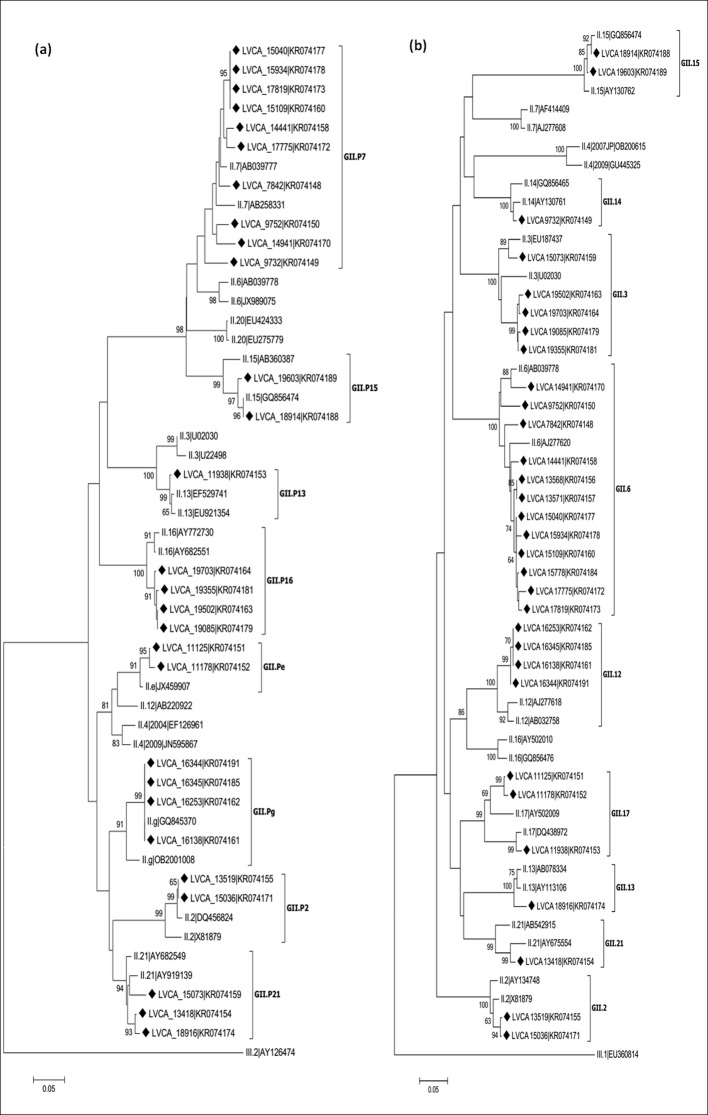
Phylogenetic analyses of NoV GII sequences based on the polymerase and capsid regions.(a) Phylogenetic tree of 231 bp within the polymerase region (3’-ORF1). (b) Phylogenetic tree of 277 bp within the capsid region (5’-ORF2). References strains of NoV genotypes are named according to GenBank with their respectively accession numbers. Brazilian GII.4 strains are marked with a filled diamond. The scale bar at the bottom of the tree indicates distance. Bootstrap values (2000 replicates) are shown at the branch nodes and values lower than 60% are not shown.